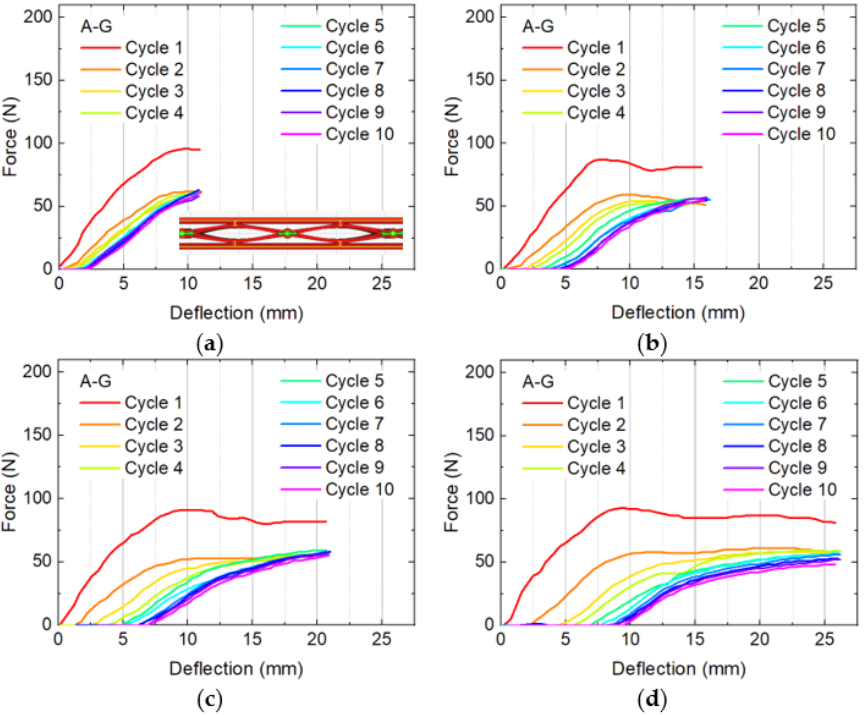
Figure 4. Bending and recovery tests of four A-G specimens with different maximum deflections: ( a ) 11 mm; ( b ) 16 mm; ( c ) 21 mm; ( d ) 26 mm.